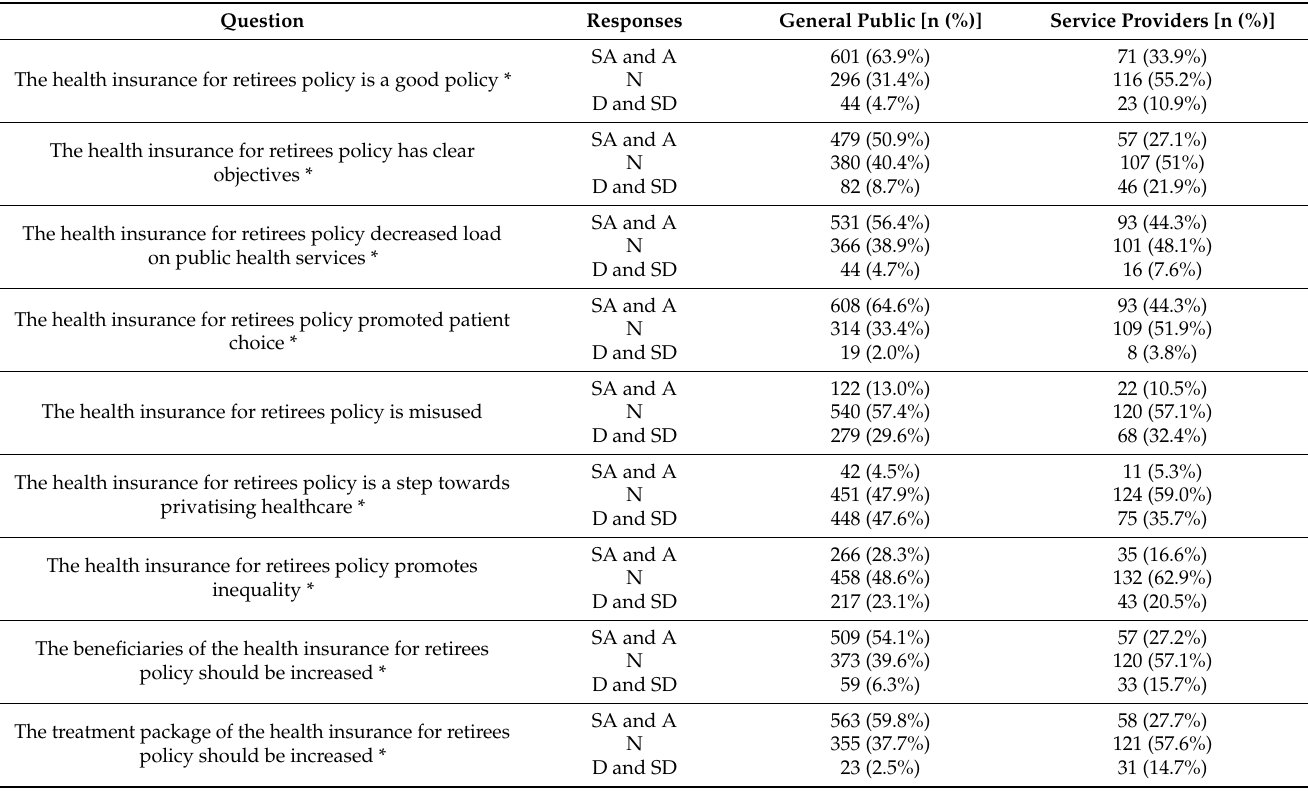
Table 11. Respondents’ opinions on the policy on private health insurance for retirees